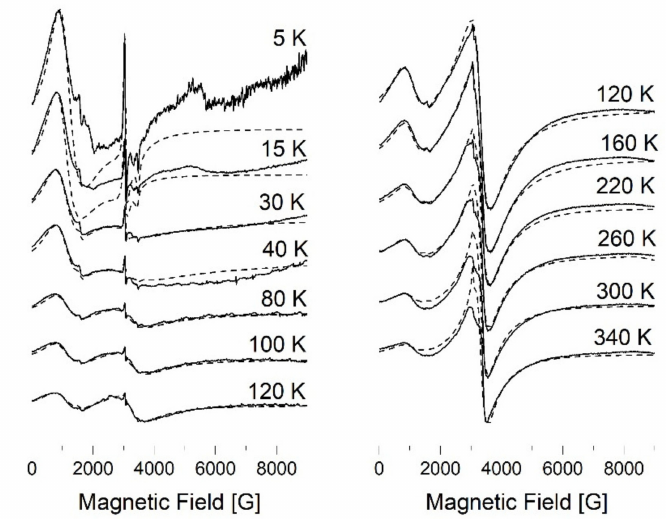
Figure 6. The temperature dependence of the EPR X-band spectra of 3 from 5 K to 340 K. The dashed lines show the theoretical EPR